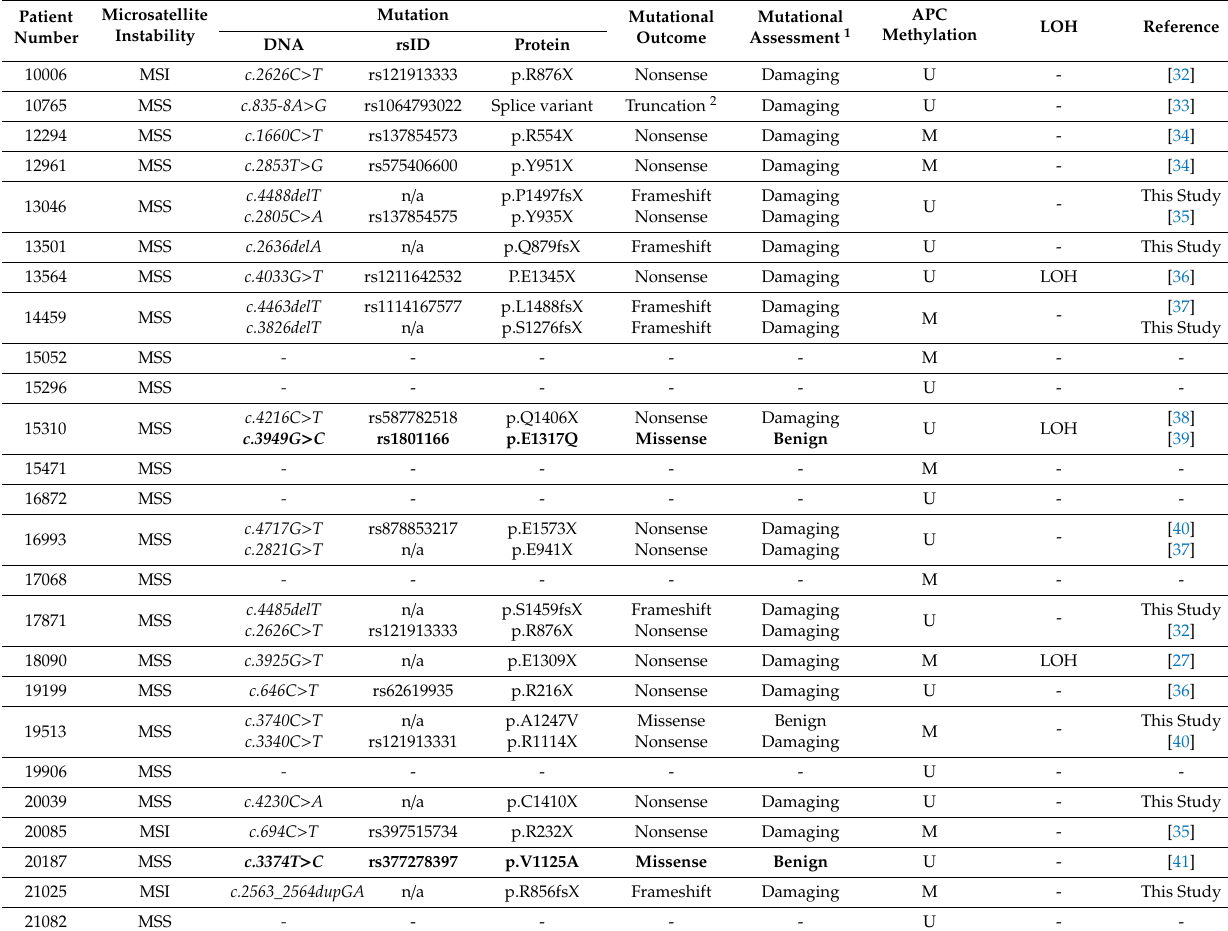
Table 2. Molecular characteristics of EOCRC